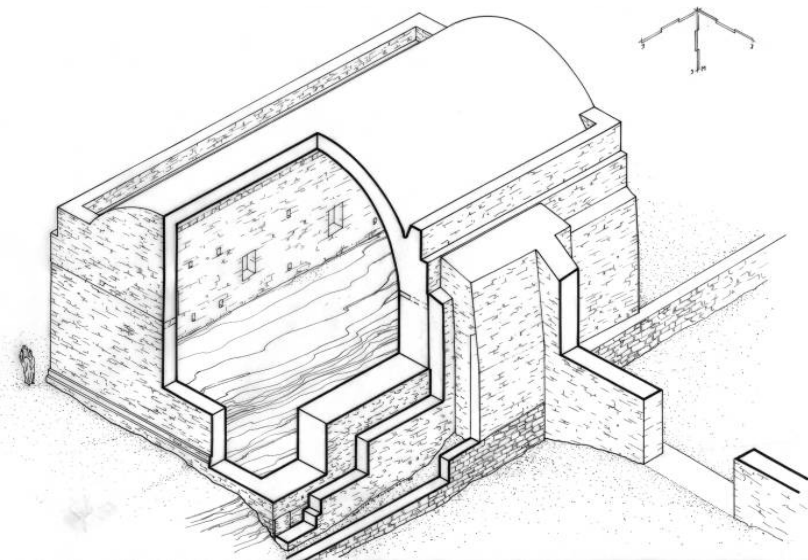
Figure 12. Cistern at Minoa on Amorgos, built on the open space of the former agora. (Reconstruction by G.P.